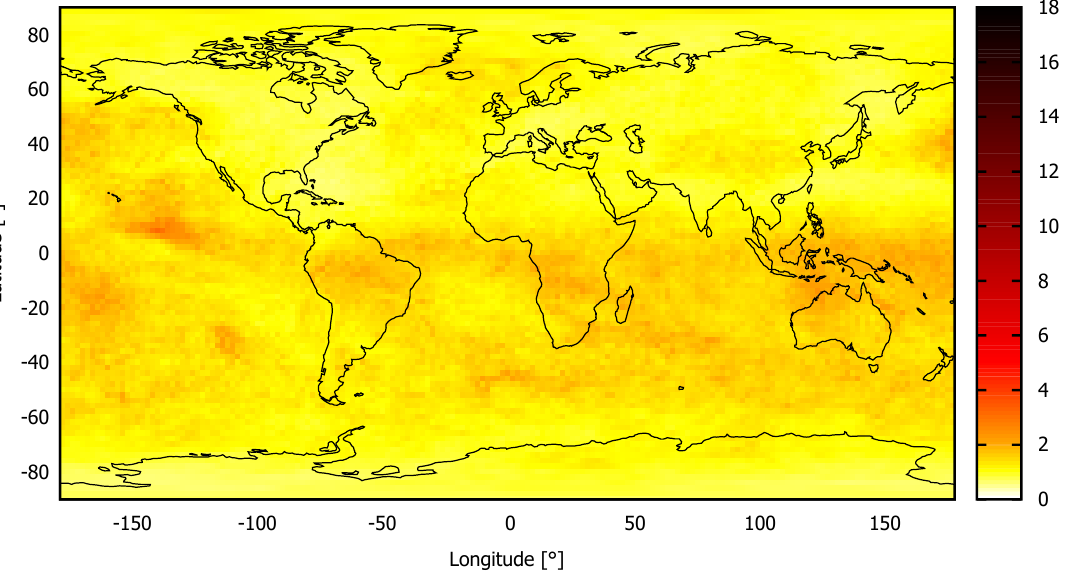
Figure 3. Monthly mean differences between the mean of 21 six-hour GEFS ensemble forecasts (calculated at 12:00 p.m./cycle 00) and the corresponding GFS model output at 6:00 a.m. in January 2020 (cycle 06). On a global average, the ensemble mean wind speed deviates 1.1 ms − 1 from the GFS model output of the same time. Maximum differences of 3.1 ms − 1 have been detected in this month.